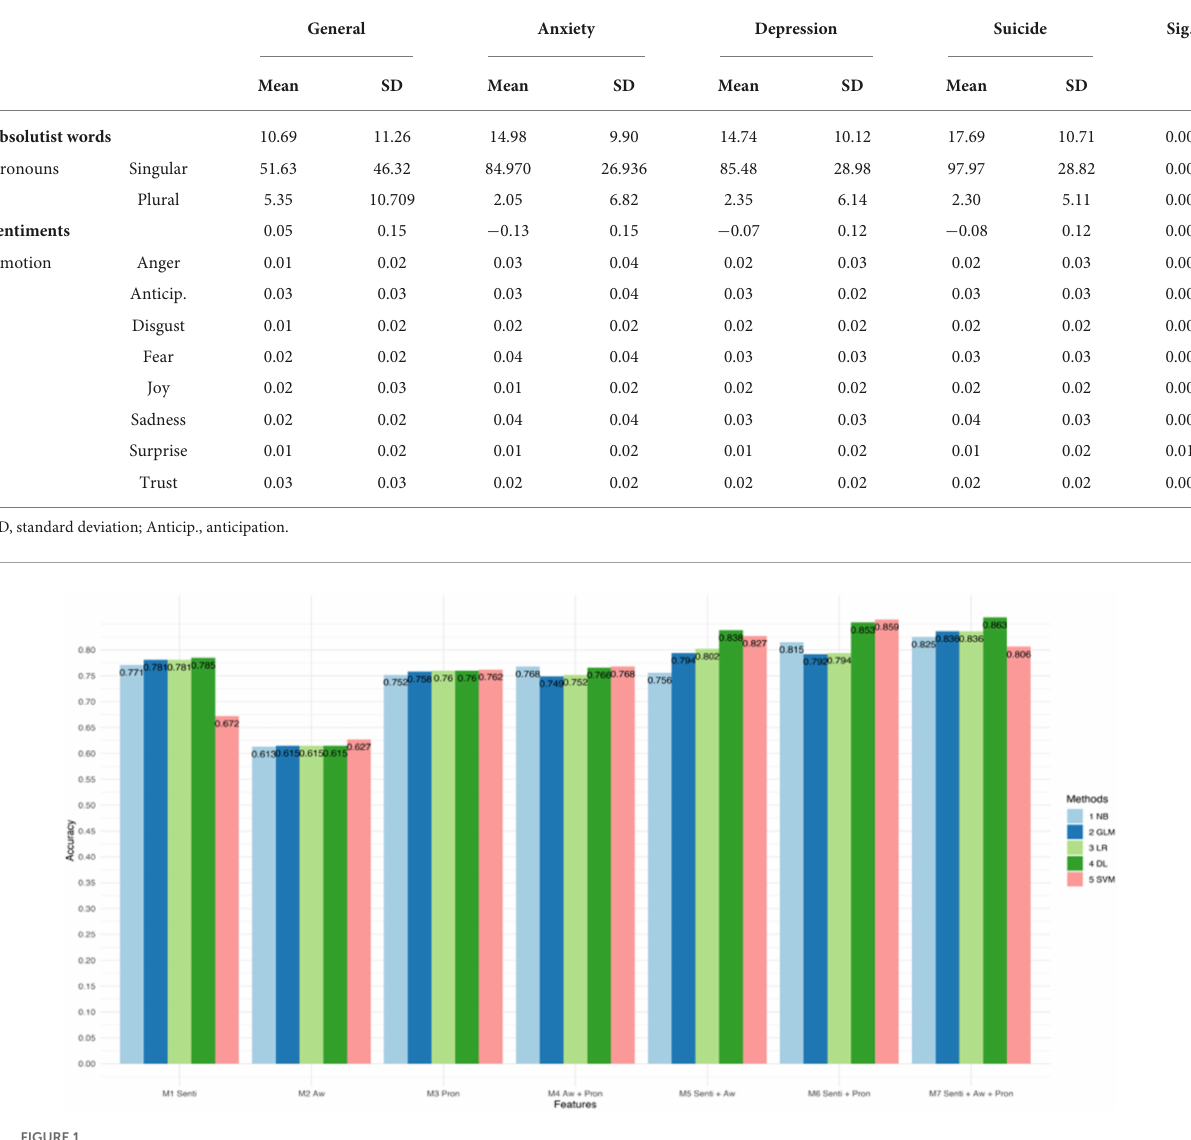
TABLE 3 Statistical results of group comparisons.